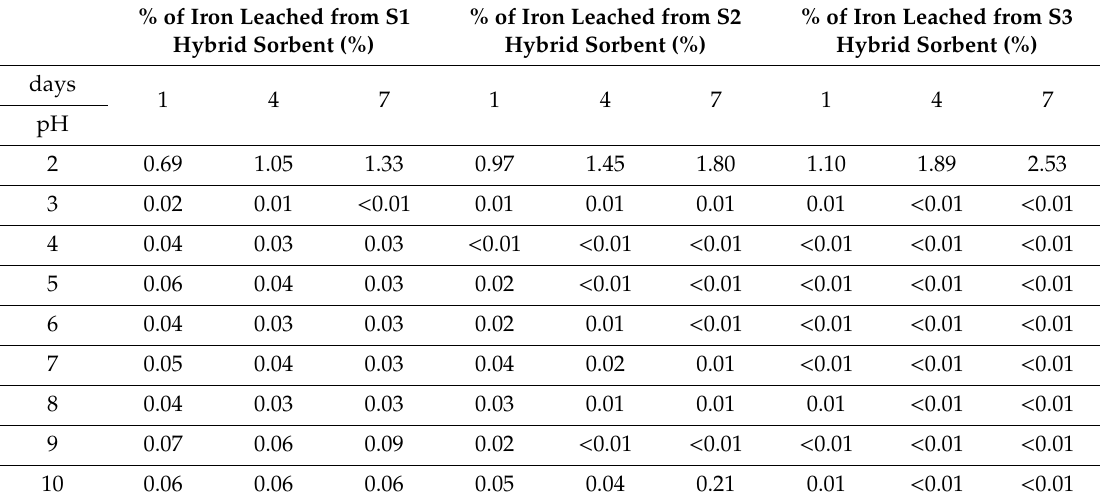
Table 2. Hybrid sorbents’ stability-leaching of